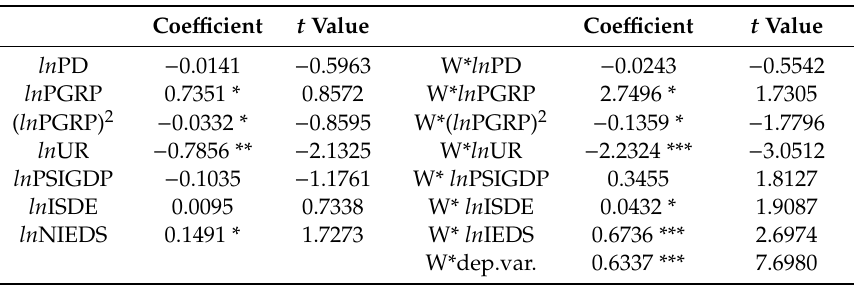
Table 5. Estimation results of SPDM with two-way